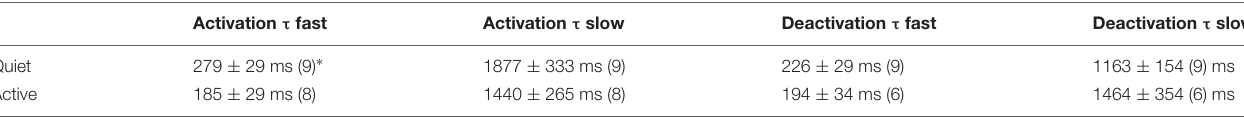
TABLE 1 | Activation and deactivation time constants of I h from quiet and active